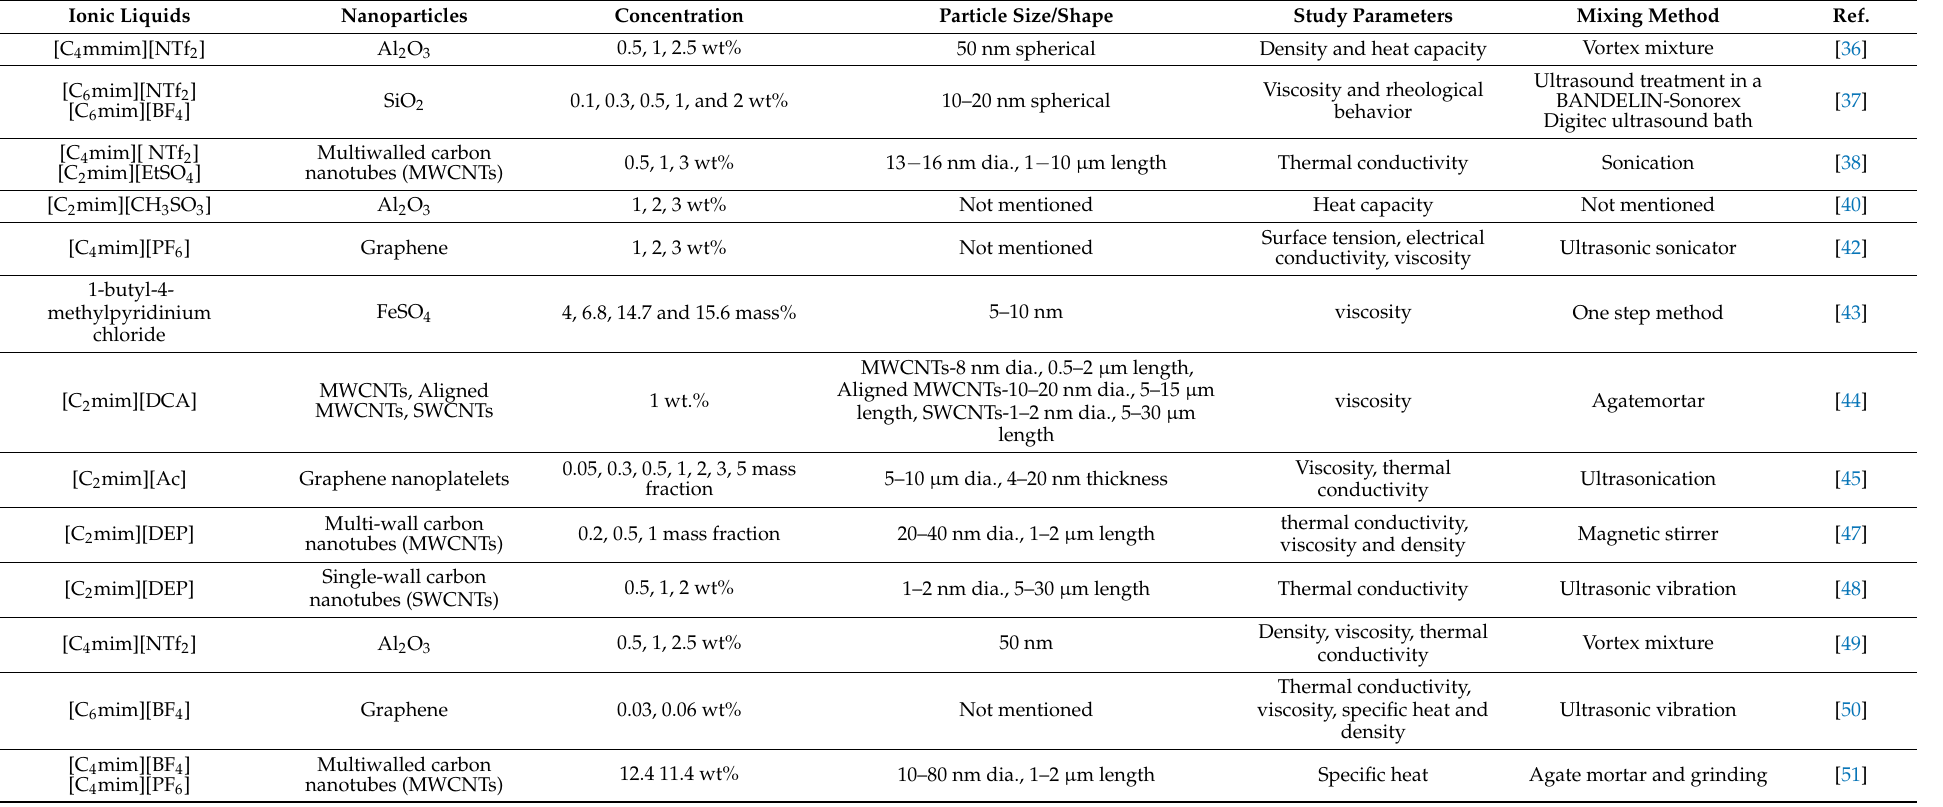
Table 2. Summary of ionic liquids-based